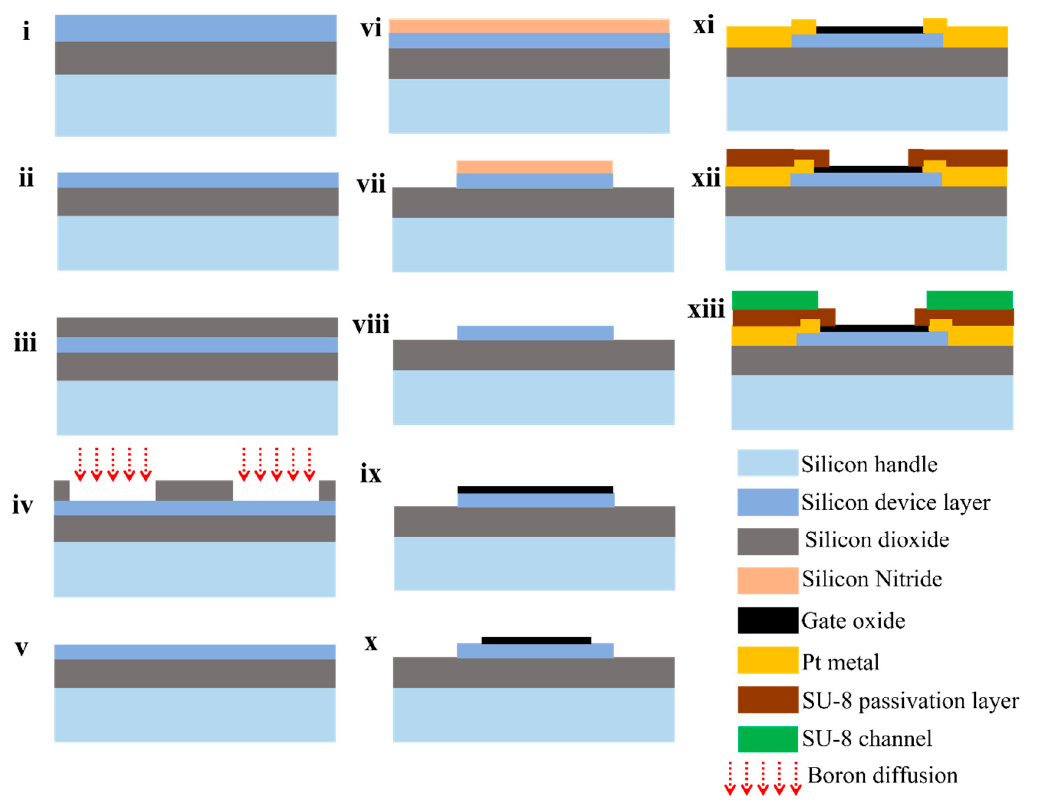
Figure 2. Fabrication process flow of the planar junctionless FETs. ( i ) cleaning SOI wafer, ( ii ) thin- ning of device layer using oxidation and etching, ( iii ) silicon dioxide growth as a masking layer, ( iv ) patterning silicon dioxide and boron diffusion, ( v ) etching silicon dioxide, ( vi ) silicon nitride depo- sition, ( vii ) patterning silicon nitride to define silicon islands, ( viii ) etching silicon nitride, ( ix ) gate oxide growth, ( x ) patterning gate oxide to define source and drain regions, ( xi ) Ta/Pt Metal lift-off, ( xii ) patterning SU-8 passivation layer, and ( xiii ) patterning SU-8 channels.